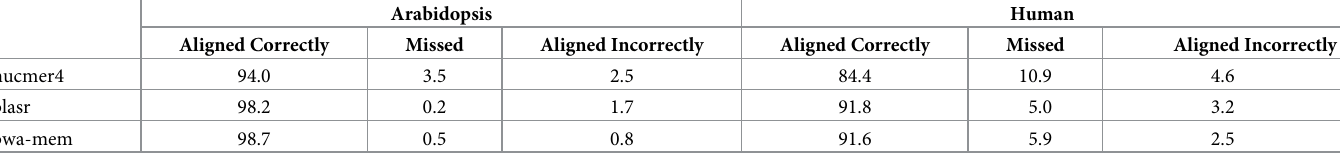
Table 5. Performance of Nucmer4, BLASR and BWA MEM on data simulated by pbsim from human and Arabidopsis reference genomes. All numbers are percent- ages from the total of bases that are in the reads aligned correctly, missed, or aligned incorrectly. The numbers may not add to exactly 100 due to rounding. Arabidopsis Human Aligned